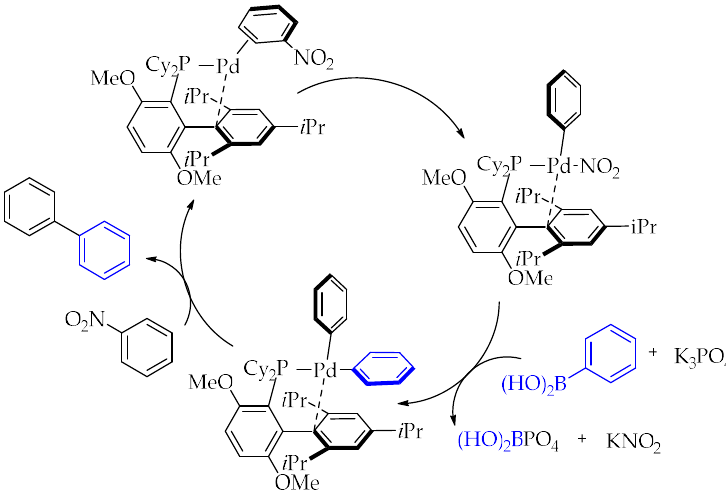
Figure 2. Plausible catalytic cycle for Pd-catalyzed SMC of nitroarenes [24].